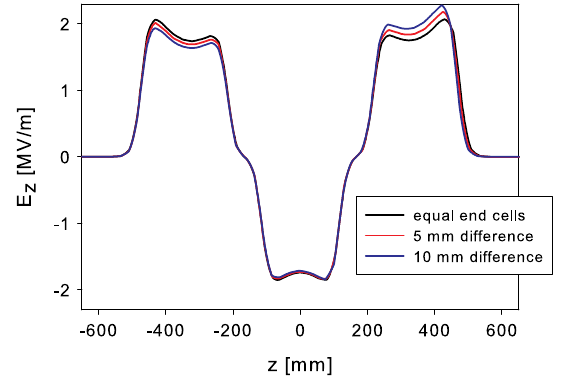
FIG. 39. On-axis electric field profile for equal end cell lengths and an imbalance of 5 and 10 mm, for an optimized 325 MHz, double-spoke cavity. The imbalances are created by adding length to one end cell while keeping the spokes fixed.